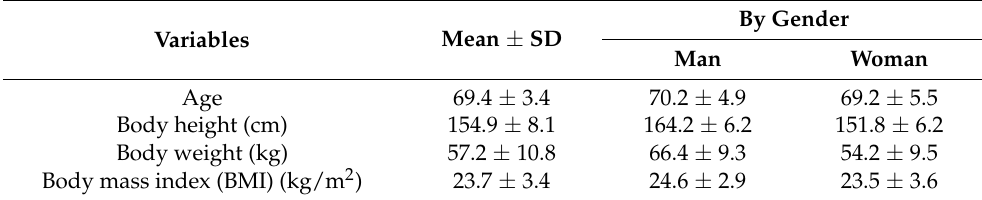
Table 1. Demographic characteristics of